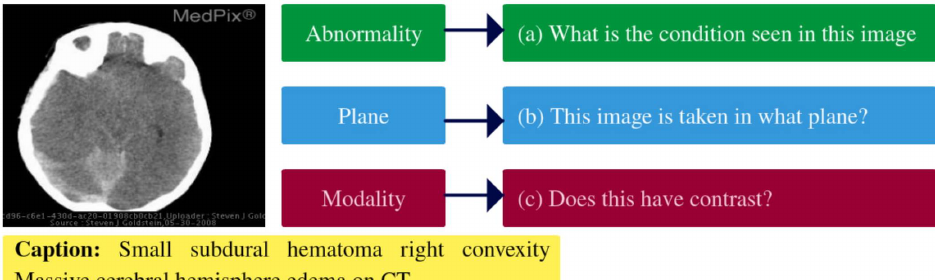
Figure 2. Examples of goal-driven questions about a radiology image. The possible questions should be relevant to the given category, also known as question type. By specifying the type of the expected question, different questions such as ( a – c ) can be generated from the same radiology